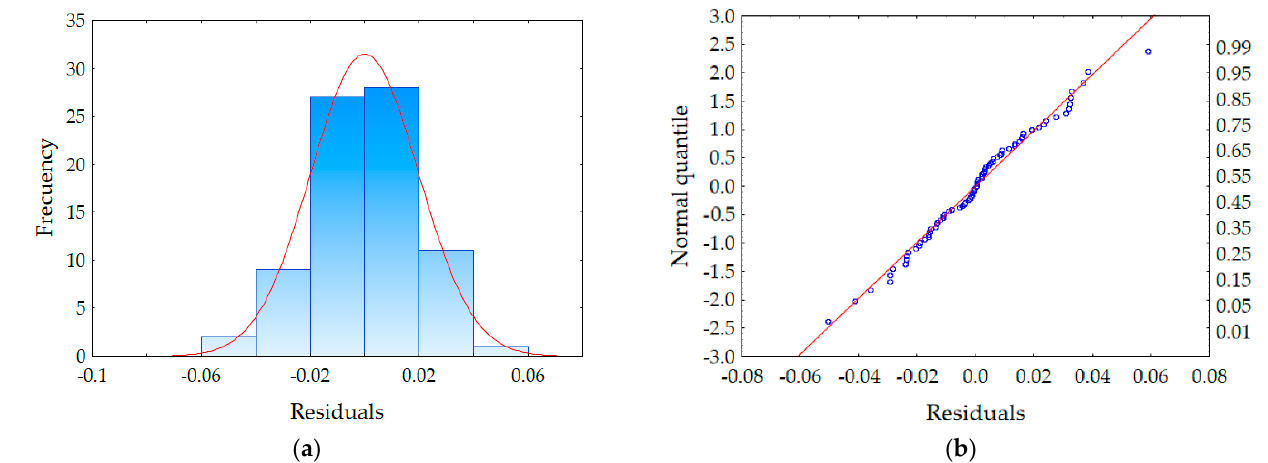
Figure 3. For the best linear effects model: ( a ) residual frequency; ( b ) residual normal quantile plots. Moderate variant: DBH alone explained 44%, and MDR alone explained 33% of the variation in wood density (WD) (Table 9, model 1 and model 2). Therefore, both DBH and MDR explained 55% of the variation in wood density (Table 9, model 3), indicating that the relationship between drill resistance and wood density is influenced by changes in